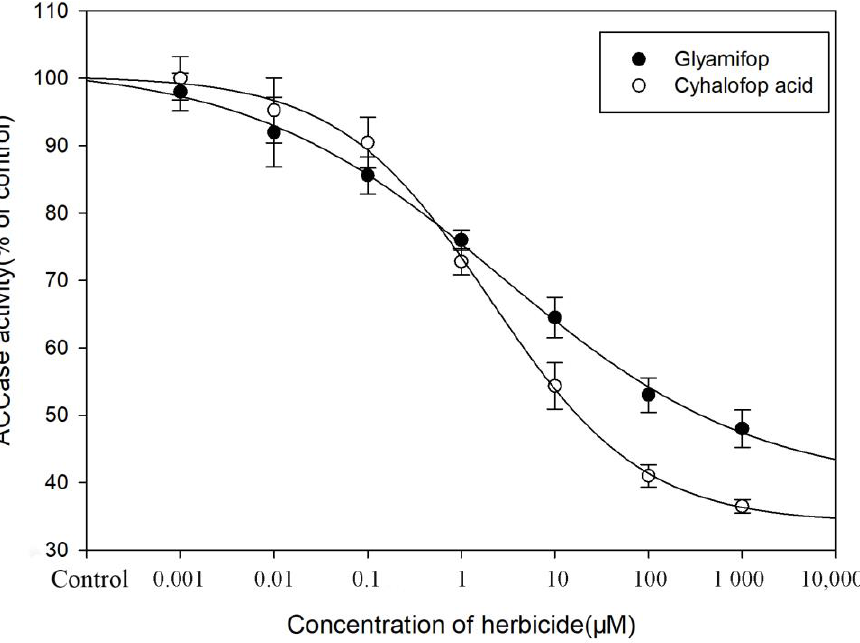
Figure 2. In vitro inhibition of Leptochloa chinensis (JNLH-4) ACCase activity by Glyamifop and cyhalofop acid.